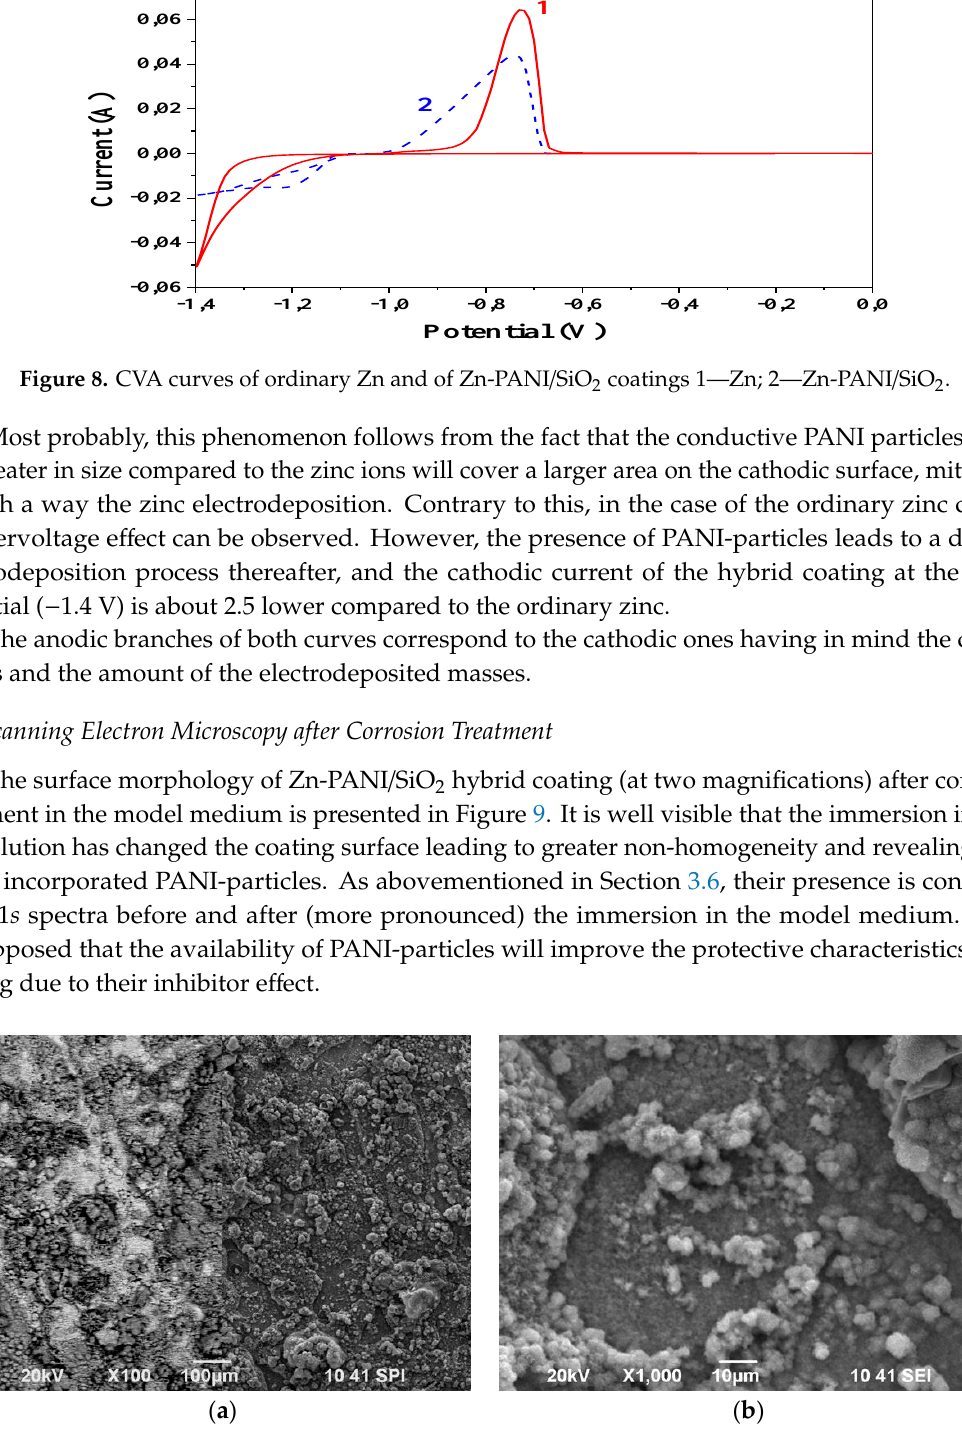
Figure 9. SEM after corrosion treatment of Zn-PANI/SiO 2 hybrid coating. ( a ) — magnification ×100; ( b ) — magnification ×1000.